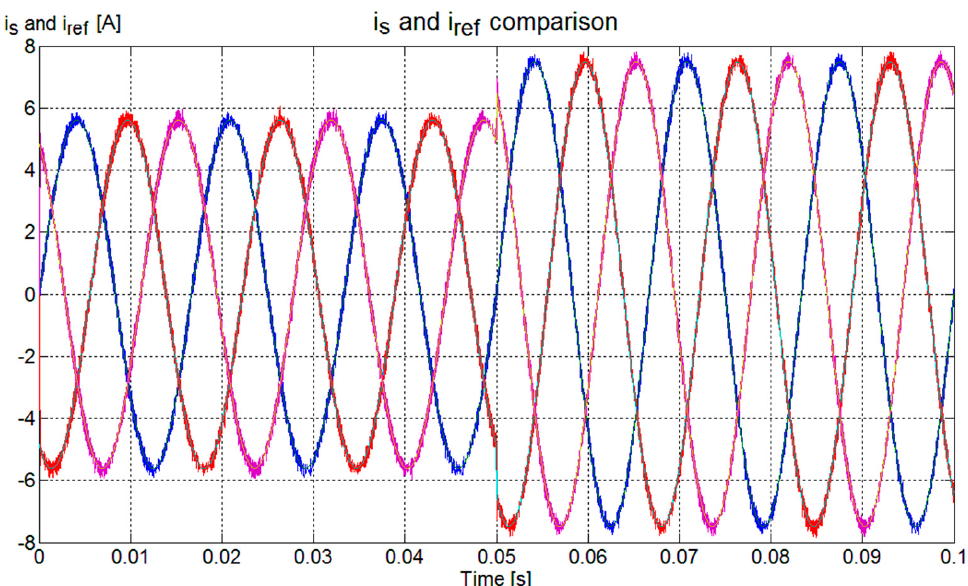
Figure 13. Reference source current waveform, i ref , and measured current waveform, i s (red, blue and violet), when a power step from 1.5 kW to 2 kW is applied at 50 ms.